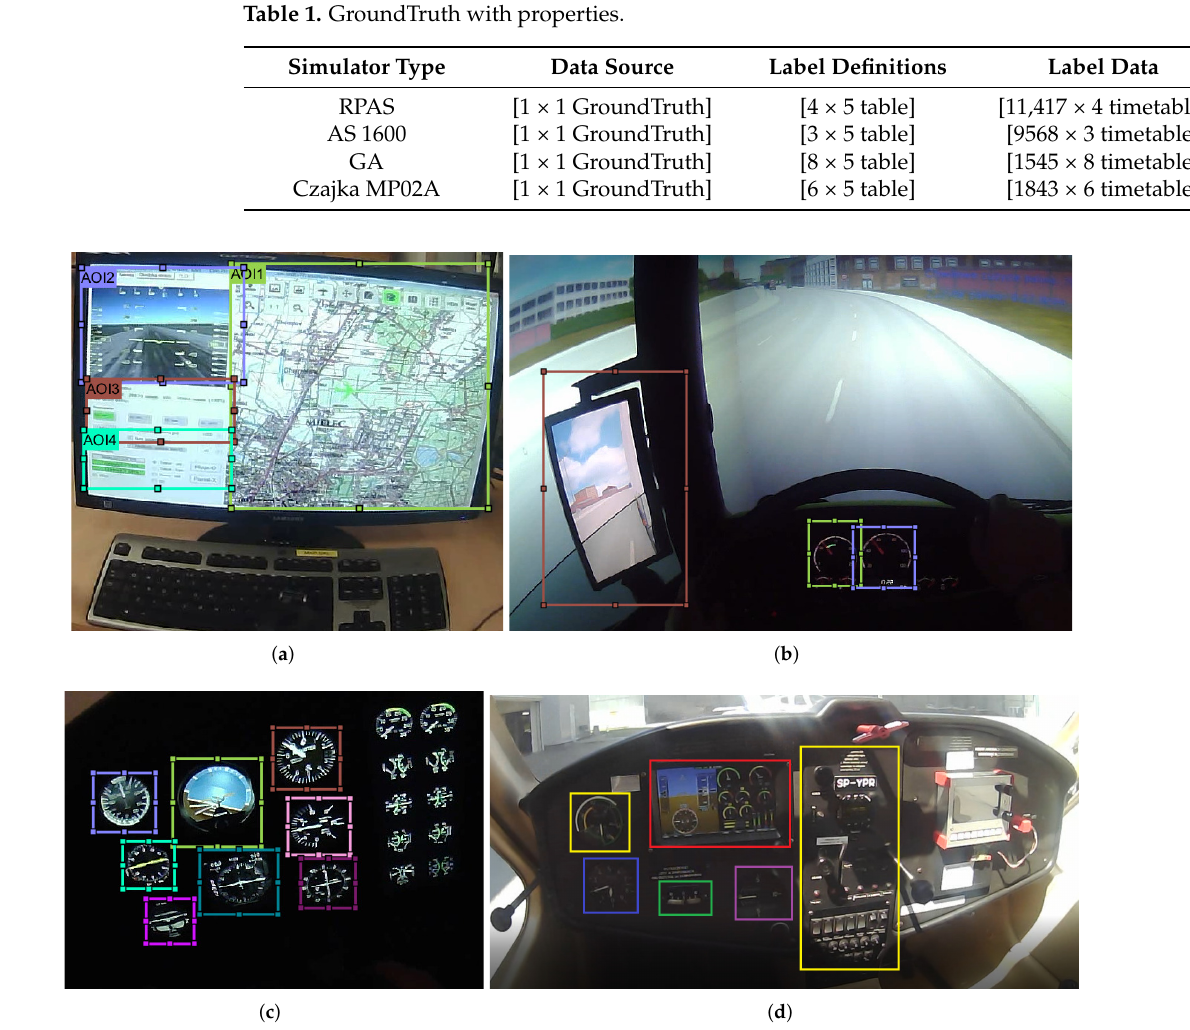
Figure 5. List of areas of interest that were used to build a training set for DNN networks, RPAS cockpit ( a ), truck simulator cockpit ( b ), GA cockpit ( c ) and flying lab cockpit ( d